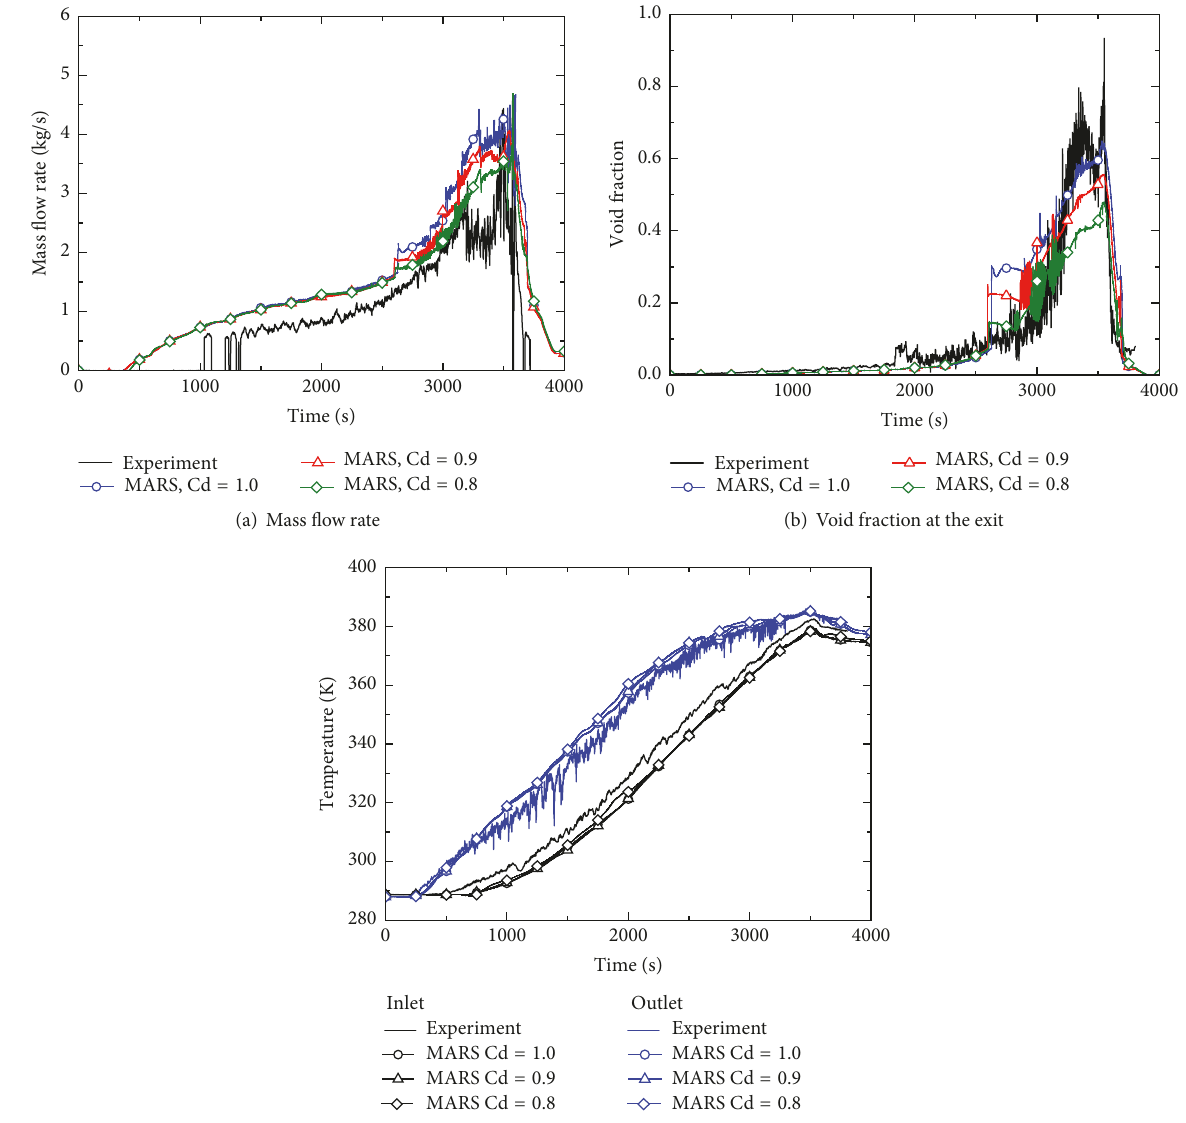
Figure 10: Sensitivity calculations for the interfacial drag: Case